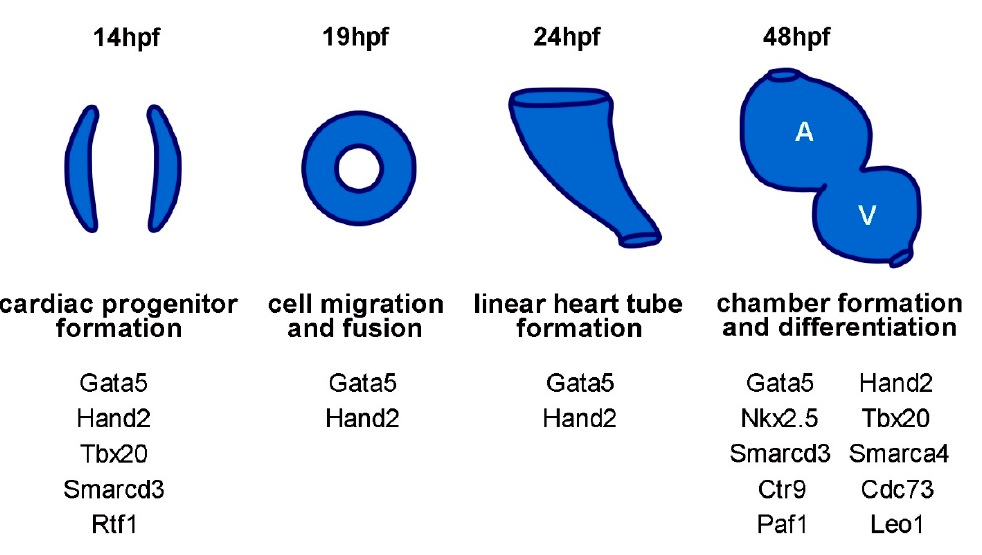
Figure 1. (Upper panel) Overview of zebrafish heart development. By 14 hpf, cardiac progenitors have emerged from the anterior lateral plate mesoderm. These cardiac precursors migrate and fuse at the midline to form a cone structure by 19 hpf. After one day of development, a beating linear heart tube has formed to propel circulation through the body. Cardiac chambers are clearly demarcated and looping has completed after two days of development. (Lower panel) Genes discussed in this review are listed below the developmental processes that they regulate. V, ventricle; A, atrium.